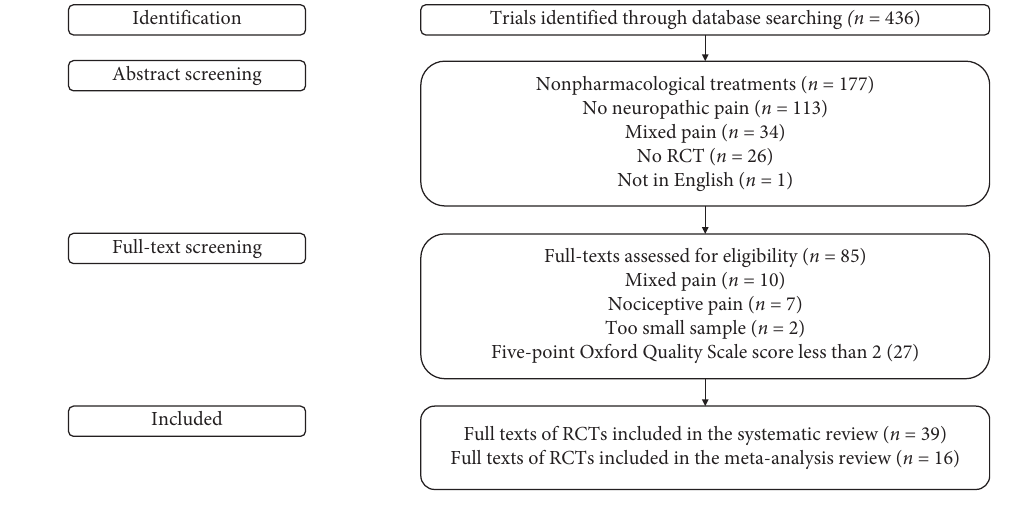
Figure 1: Flowchart of the search Table 1: Randomized, double-blind, controlled trials testing the effect of antidepressants.